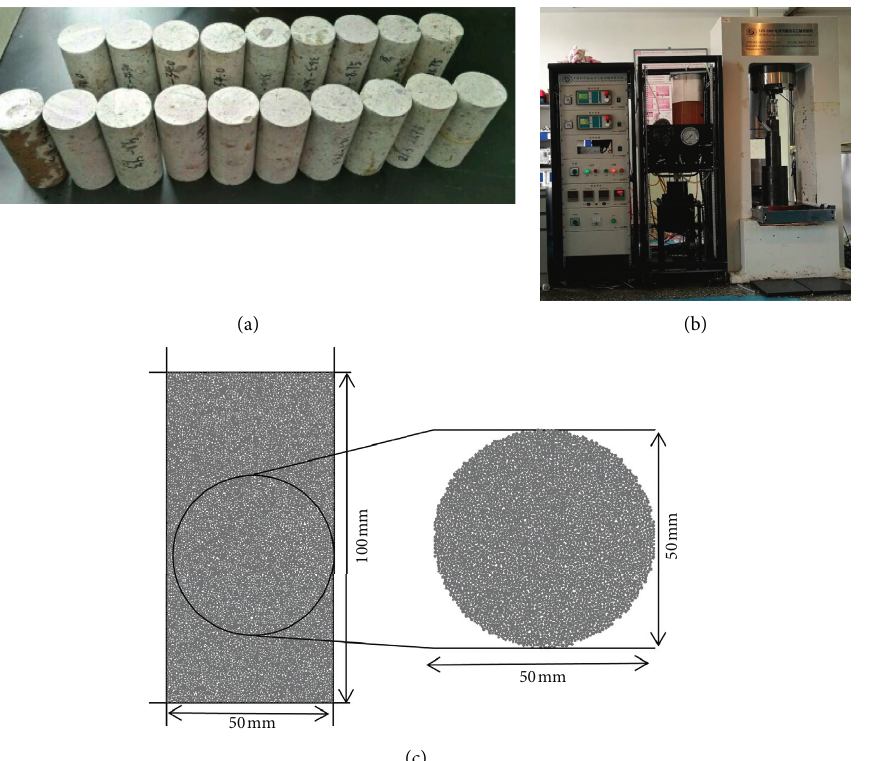
Figure 5: Intact samples cored from the Xiabeishan tunnel and numerical specimen. (a) Tested samples in the lab test. (b) Test equipment. (c) Numerical specimen generated for compression and Brazilian tensile strength tests in PFC 2D